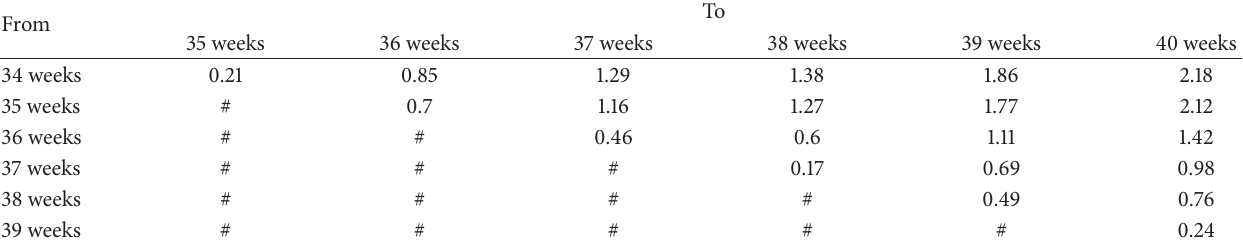
Table 3: Cohen 𝑑 coefficients of effect size at different intervals.